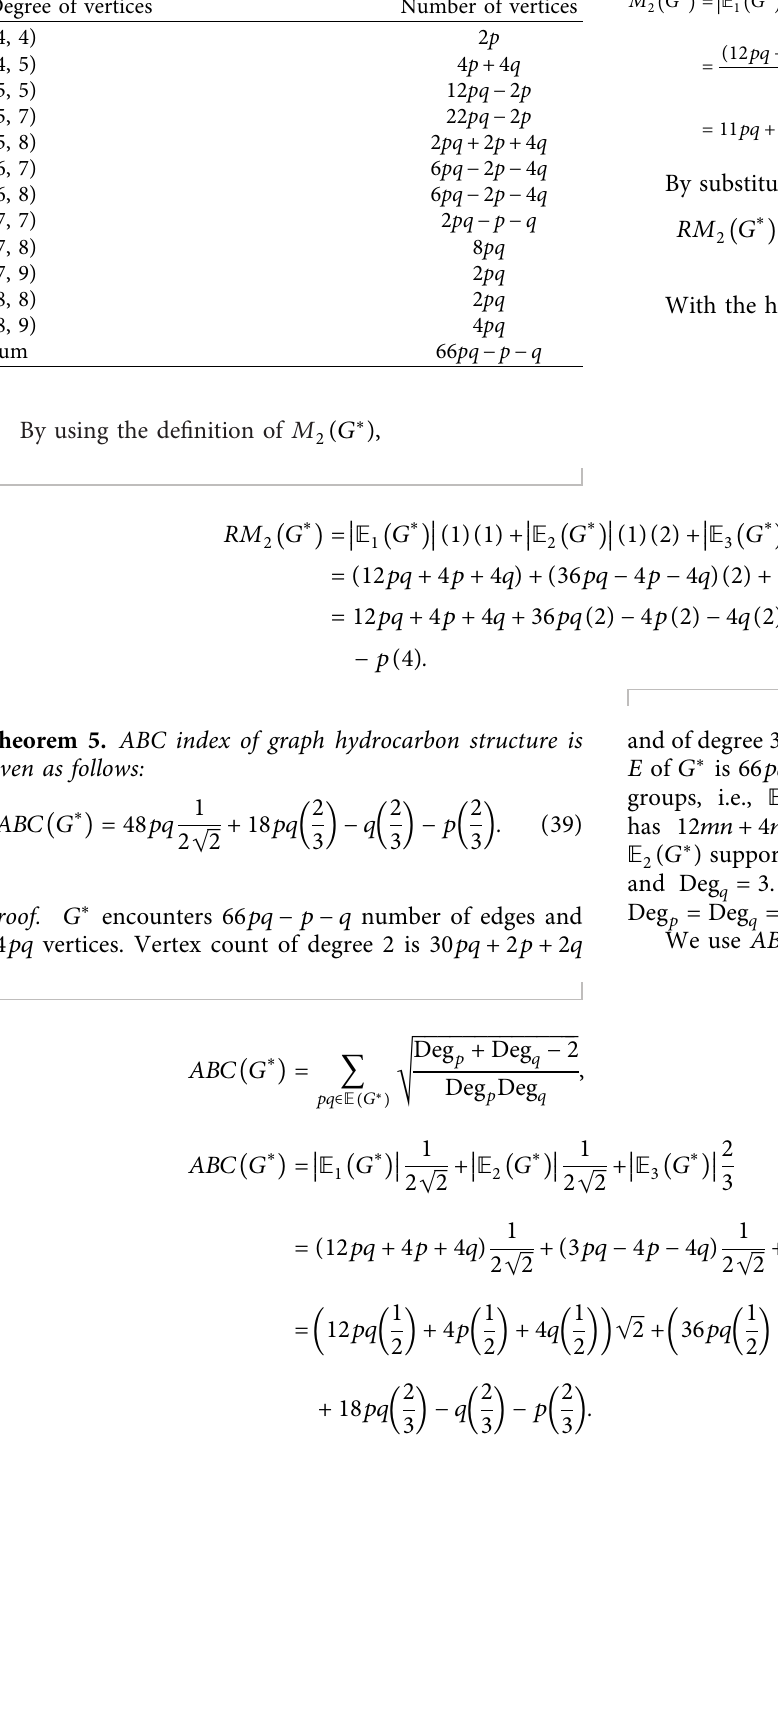
Table 4: Edge grouping of a graph G ∗ of hydrocarbon structure with accordance of degree summation of adjoining end vertices of every edges. Degree of vertices